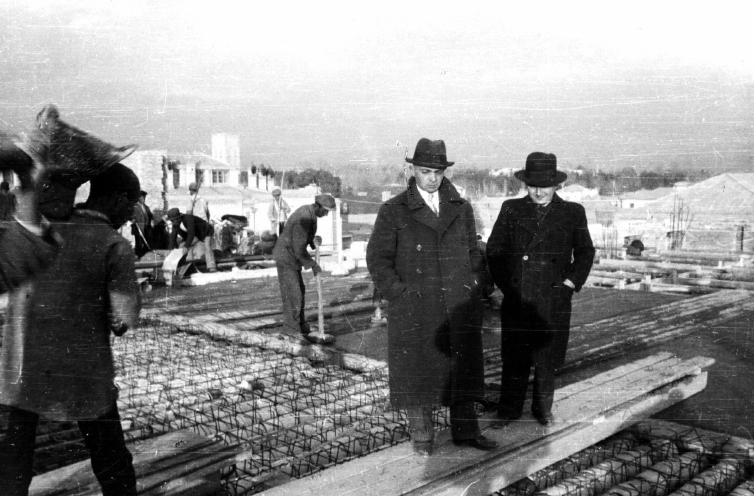
Figure 5. Gabriel Guevrekian on the roof of the Officers’ Club, 1937. Source: Le Groupe d’Architectes de l’Ere de Evolution en Iran